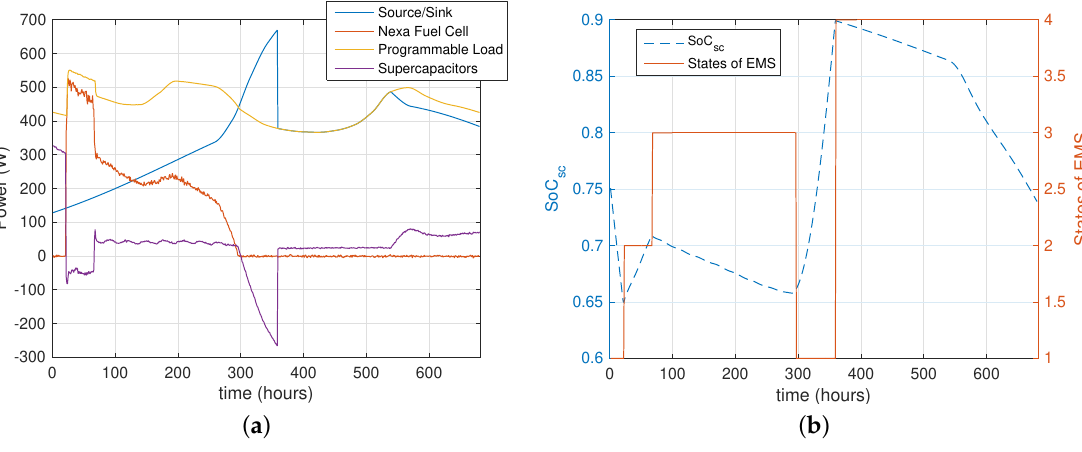
Figure 12. Laboratory station power profiles: ( a ) source/sink, programmable load, Nexa TM fuel cell, Maxwell TM SC; ( b ) (dashed line) state of charge of SCs ( SoC sc ) and (solid line) states of the